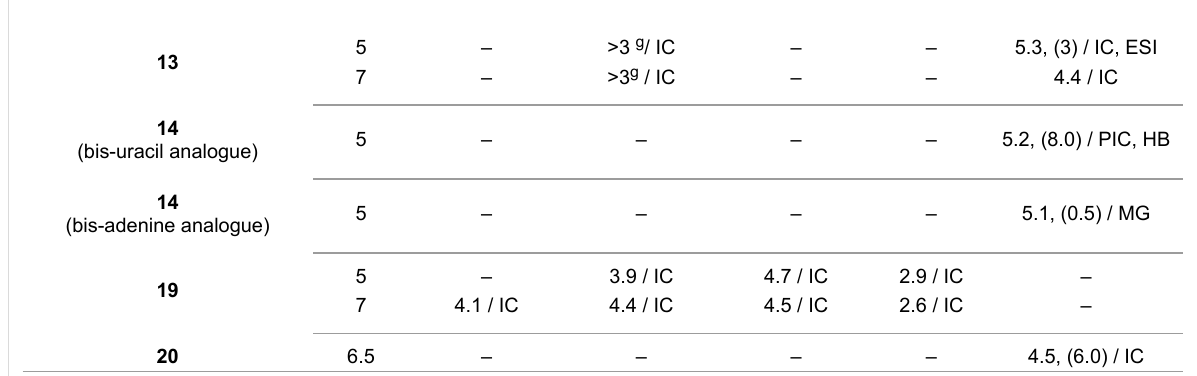
Table 2: Binding affinities (log Ks ) and proposed binding modes of chosen phenanthridine and phenanthridinium derivatives with synthetic polynuc- leotide ss-RNA.